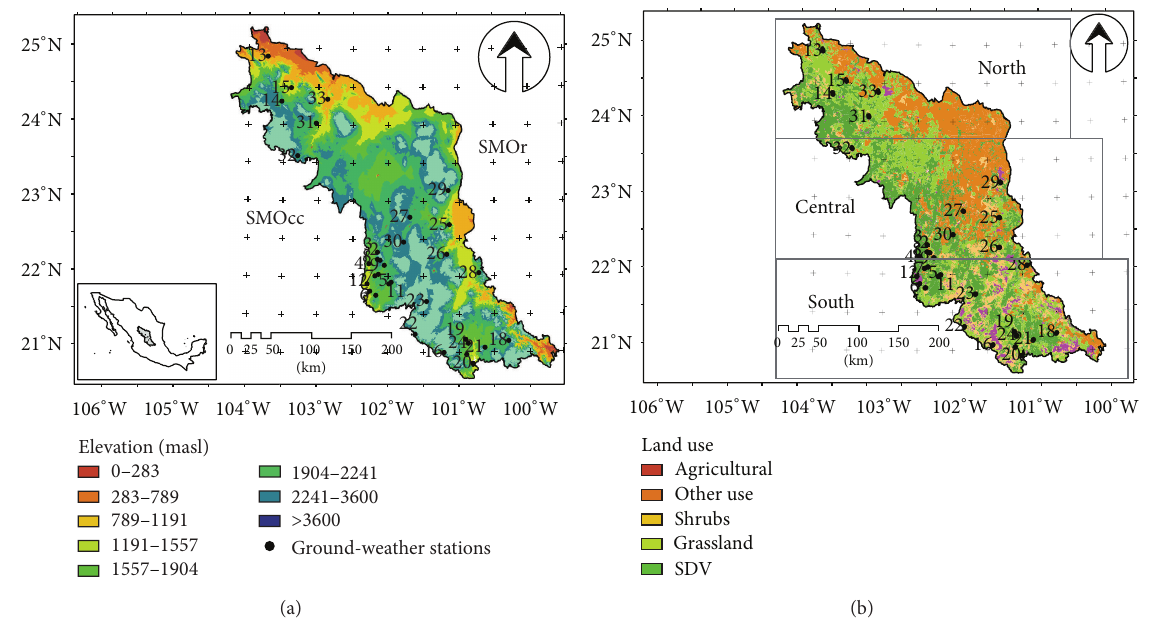
Figure 1: Digital elevation model (DEM (a)) and land use (b), along with the location of ground-weather stations. The scale is 1:250,000.